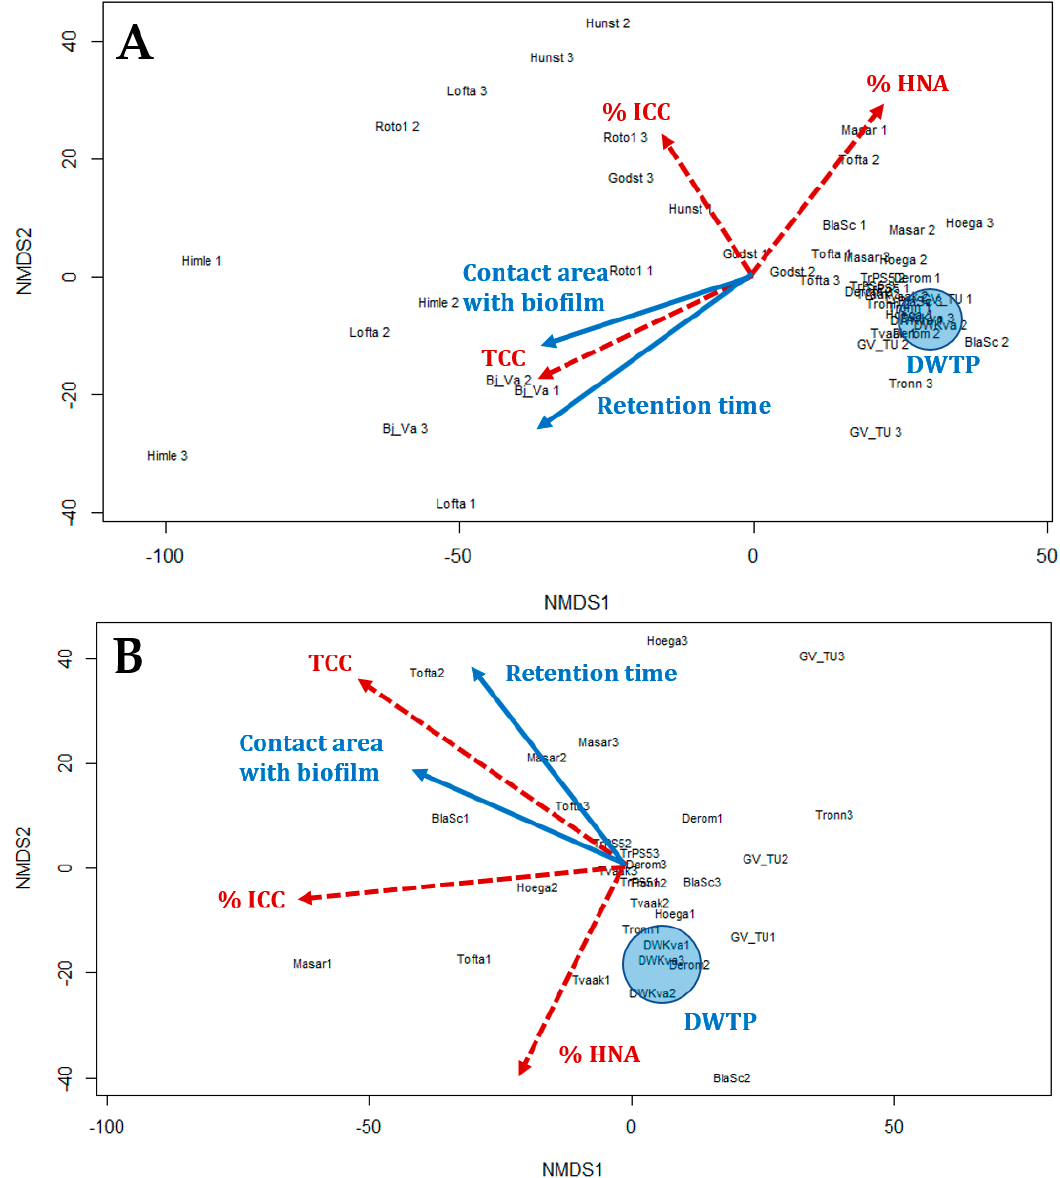
Figure 4. Output from CHIC analysis plot combined with envfit showing correlations (red dotted arrows: Bacterial community parameters; blue arrows: Distribution system parameters). Samples that are close to each other in the plot have similar bacterial profiles by FCM; vectors indicate possible correlations. ( A ) Analysis of 16 sampling points ( n = 3 for each sampling point) sampled during April and May 2018. ( B ) Analysis of 10 sampling points, selected from the 16 in ( A ) ( n = 3 for each sampling point) sampled during April and May 2018. Using the smaller subset of samples permitted a more